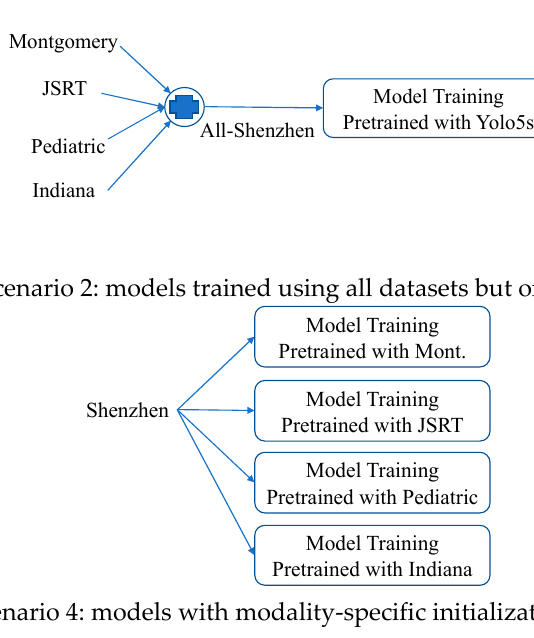
Figure 5. Diagrams of four experiments scenarios.